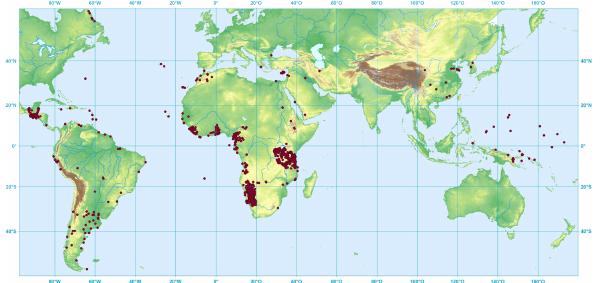
Figure 7. Position of overseas stations of German Naval Observa- tory Hamburg